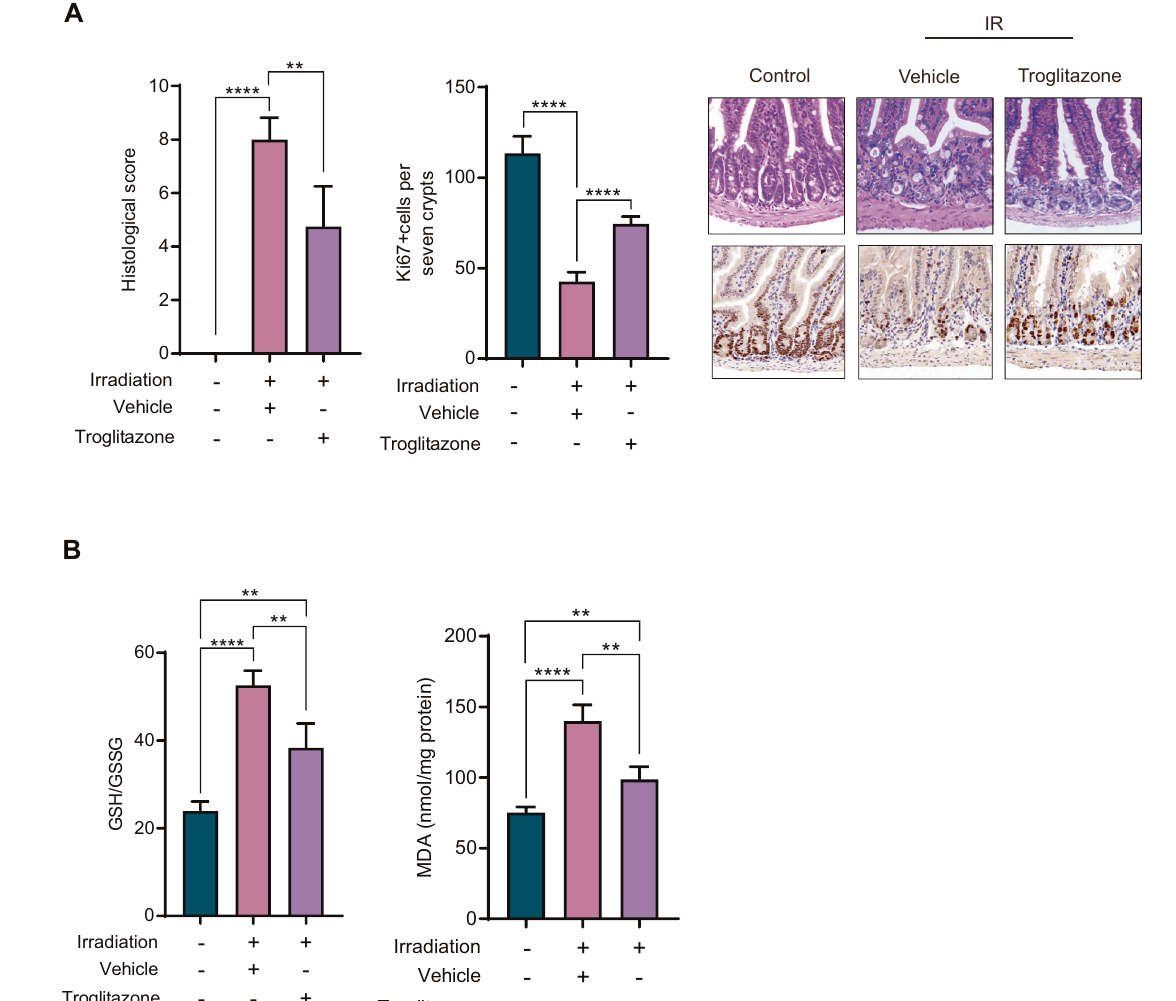
Fig. 5 Intestinal bacteria and fungi promote ferroptosis by inducing ACSL4 expression. A Histological scores of intestinal tissues of mice after IR. Ki67 + cells were counted in seven crypts. Representative images of the H&E staining and Ki67 staining of the intestine from control, vehicle, and troglitazone. B Analysis of GSH/GSSG and MDA in intestinal control, vehicle, and troglitazone of mice. P values are derived from permutation test, two-sided Student ’ s t test. * p < 0.05, ** p < 0.01, *** p < 0.001, **** p <